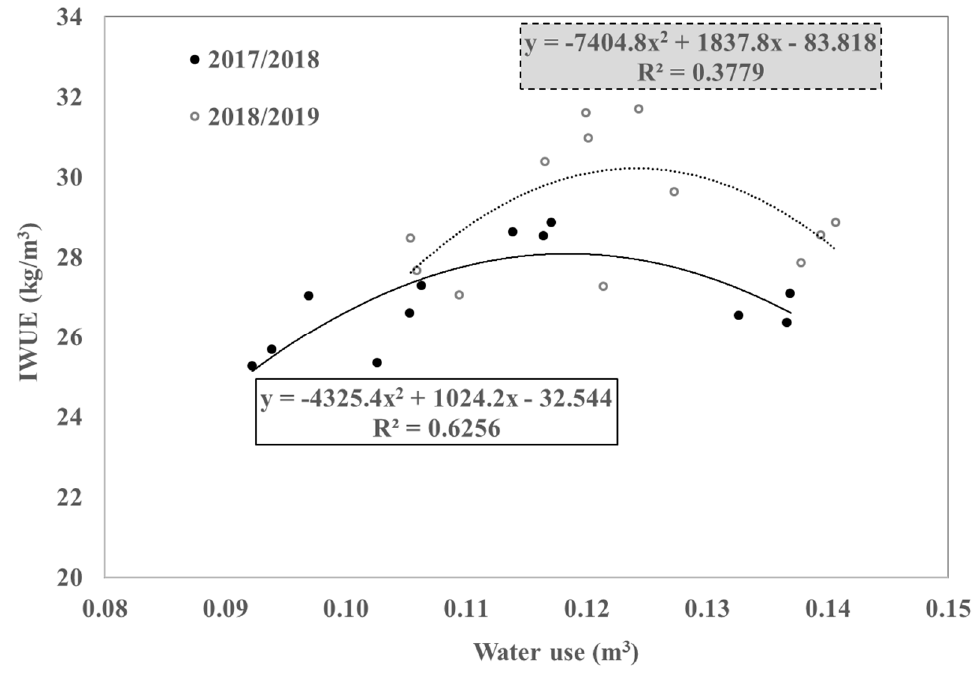
Figure 6. The effect of applied water on IWUE of greenhouse tomato in 2017–2018 and 2018–2019. Figure 6. The e ff ect of applied water on IWUE of greenhouse tomato in 2017–2018 and